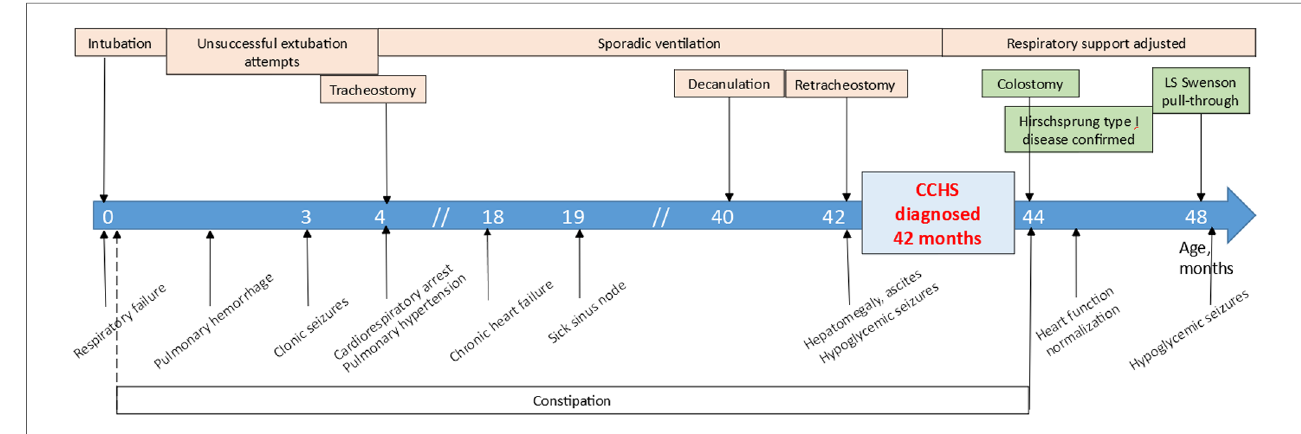
FIGURE 4 The disease course of the